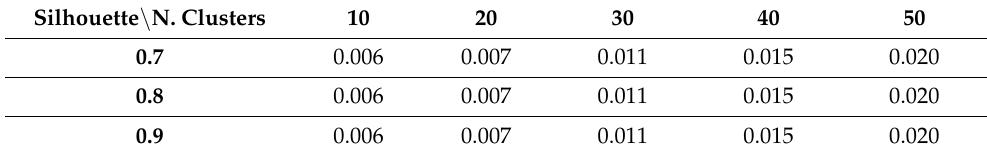
Table 52. Clustering performance in terms of silhouettes using normalized data. Silhouette \ N. Clusters